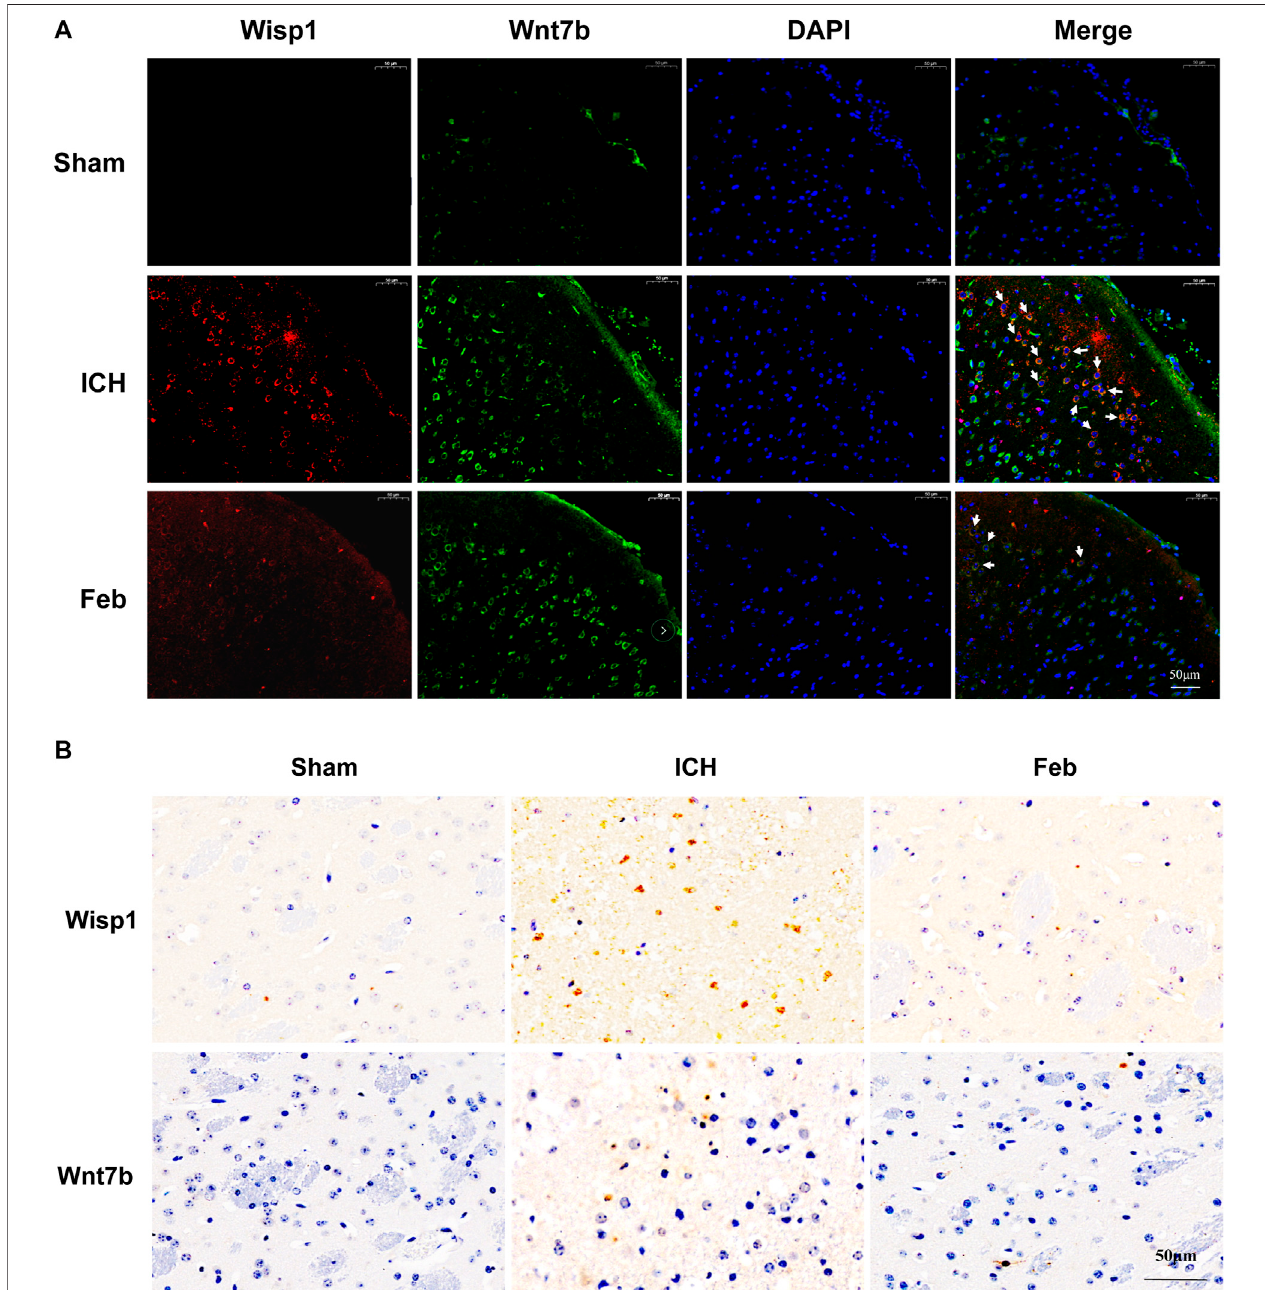
FIGURE 7 | Expression of Wisp1 and Wnt7b in mice: (A) Expression of Wisp1 and Wnt7b in the perihematomal area observed by immuno fl uorescence labeling. Wisp1 is shown in red and Wnt7b is shown in green. White arrows indicate colocalization. Sections were stained with DAPI (blue) to show all nuclei. The scale bar is 50 μ m. (B) Expression of Wisp1 and Wnt7b in the perihematomal area. The scale bar is 50 μ m.